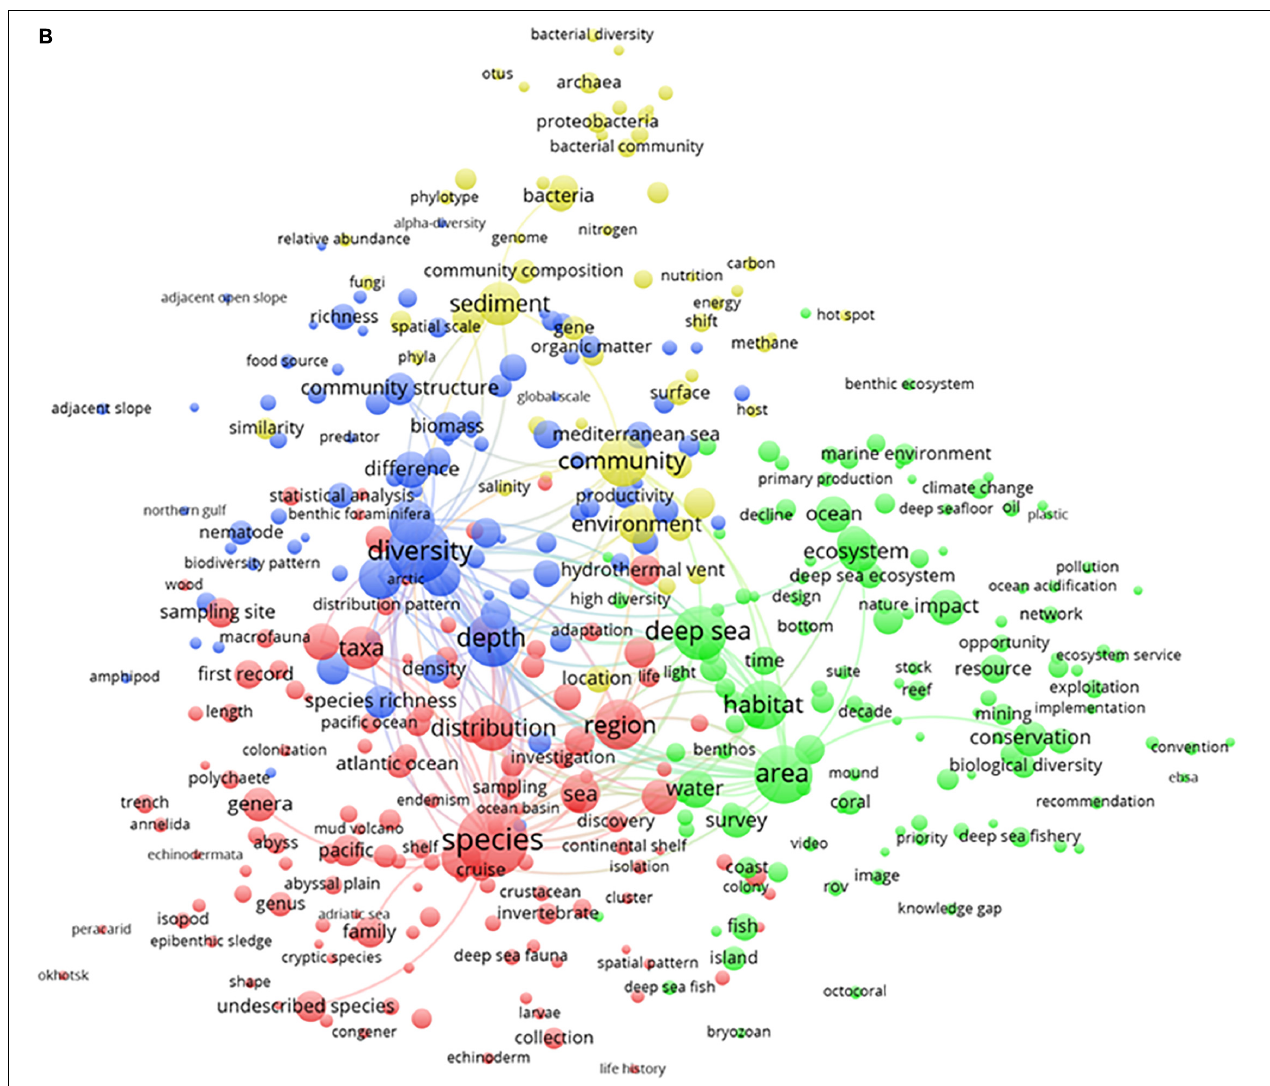
FIGURE 4 | Term map analysis conducted on two different periods: (A) from 1993 to 2010 and (B) from 2011 to 2019. Colors are used to identify clusters of related terms and are chosen arbitrarily. Different colors represent the terms belonging to different clusters (see detailed explanation in the text). Lines indicate at least 100 co-occurrence links between